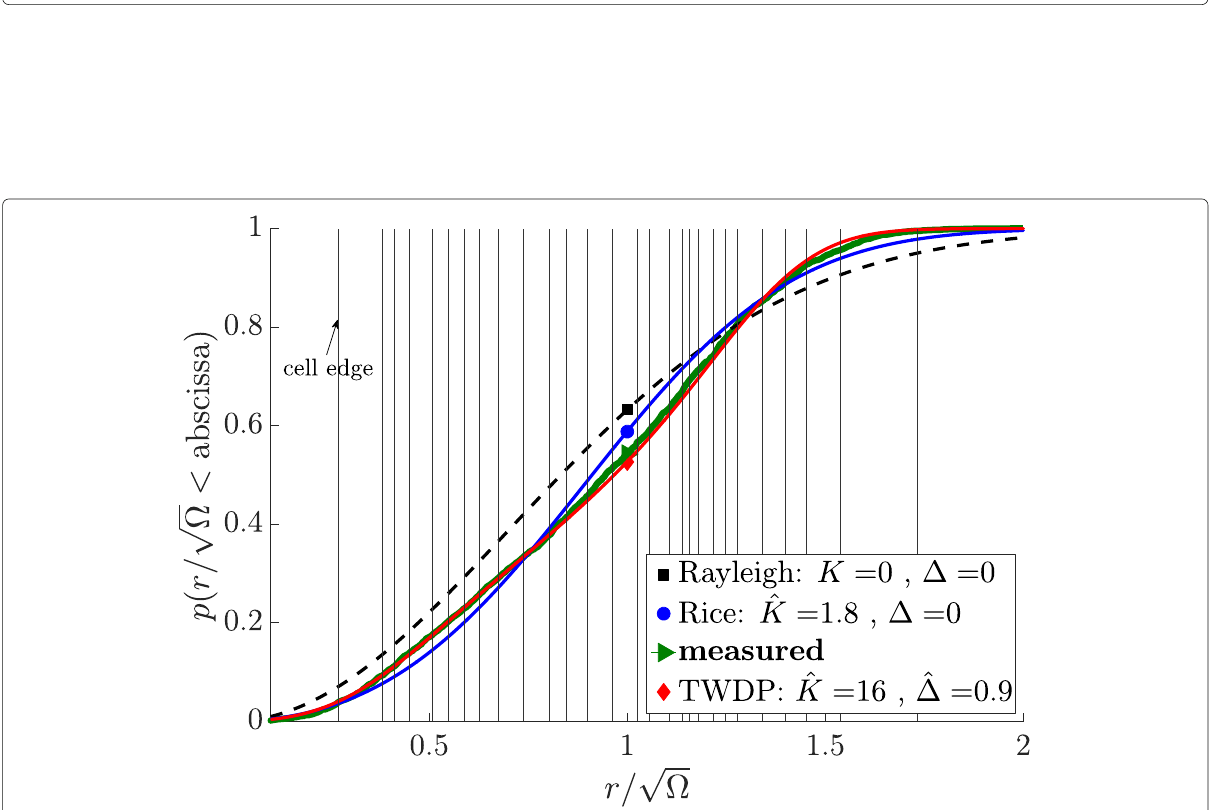
Fig. 2 CDFs: Distribution fitting for exemplary frequency domain measurement data. Illustration of the maximum likelihood fitted Rice distribution and the maximum likelihood fitted TWDP fading distribution. The Rician K -factor and the TWDP K -factor deviate significantly. Rayleigh fading is plotted as